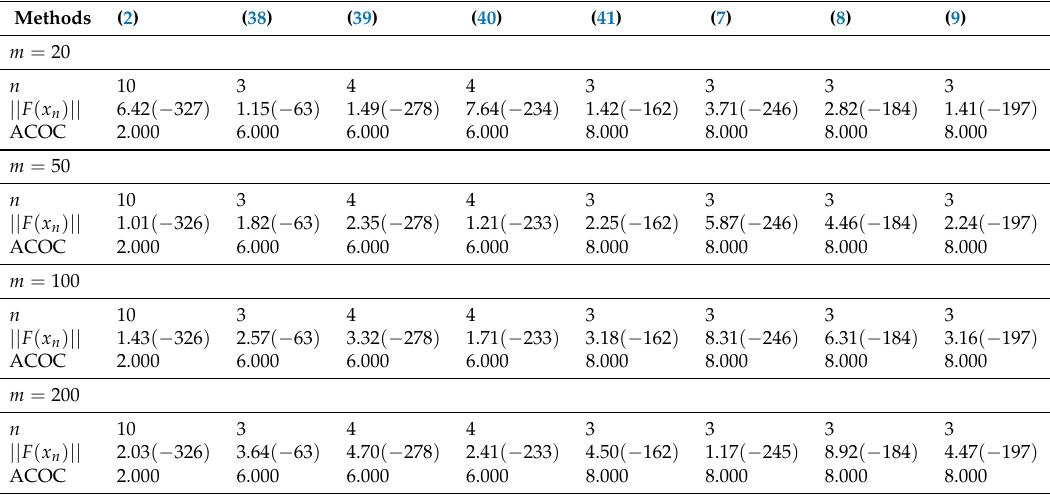
Table 5. Comparison of performance of methods for Example